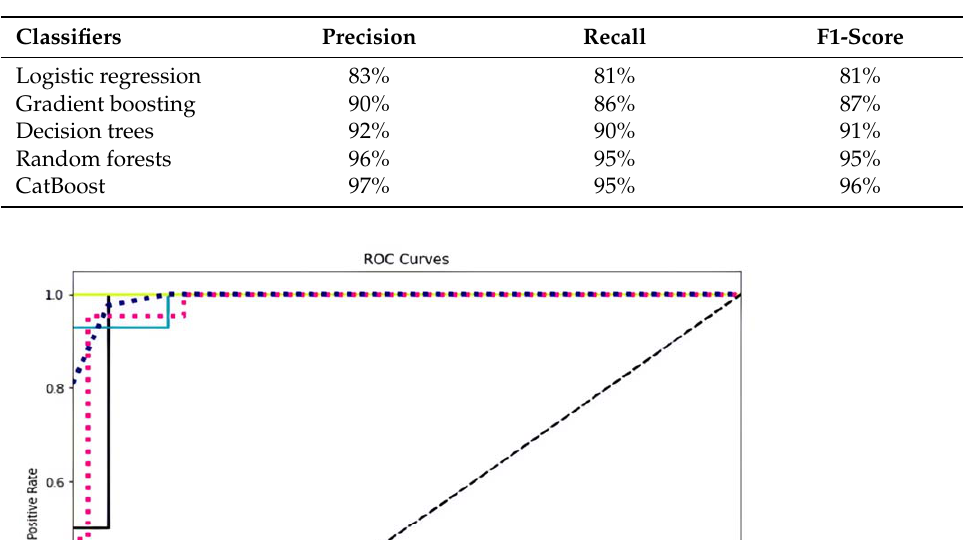
Figure 3. Scatterplots of the NT (green circles), ST (blue circles), and MT (orange circles) samples of combined features derived via PCA before ( A ) and after ( B ) SMOTE. Synthetic samples generated by SMOTE in minority categories are shown (dark blue: ST; dark green: NT). The X ‐ and Y ‐ axes in each graph represent combinations of all features used in the experiments. Table 2. Results of metrics to evaluate each classifier model.